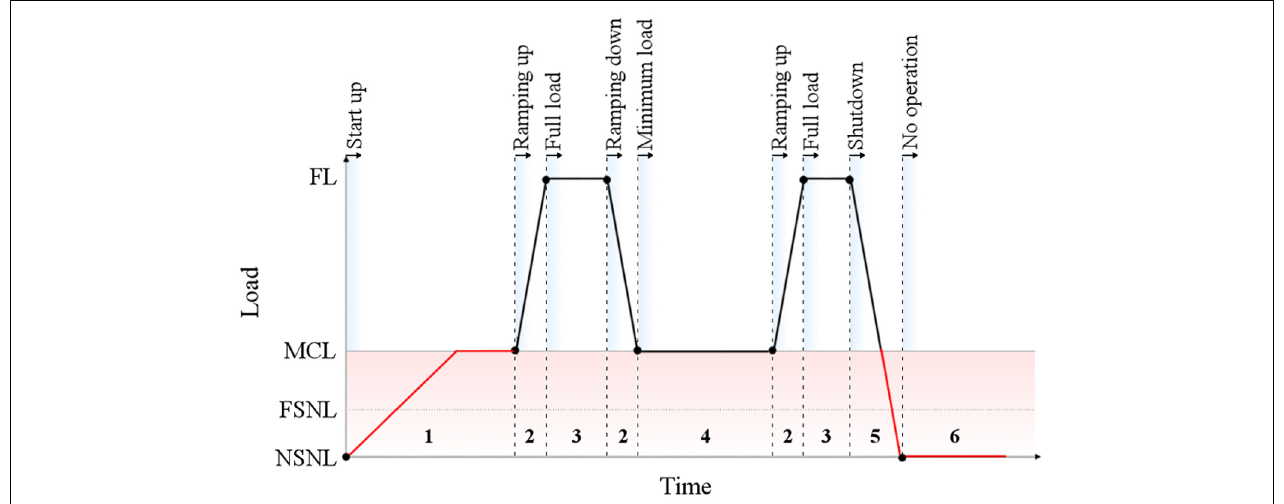
FIGURE 2 | Types of process during the operation of a combined